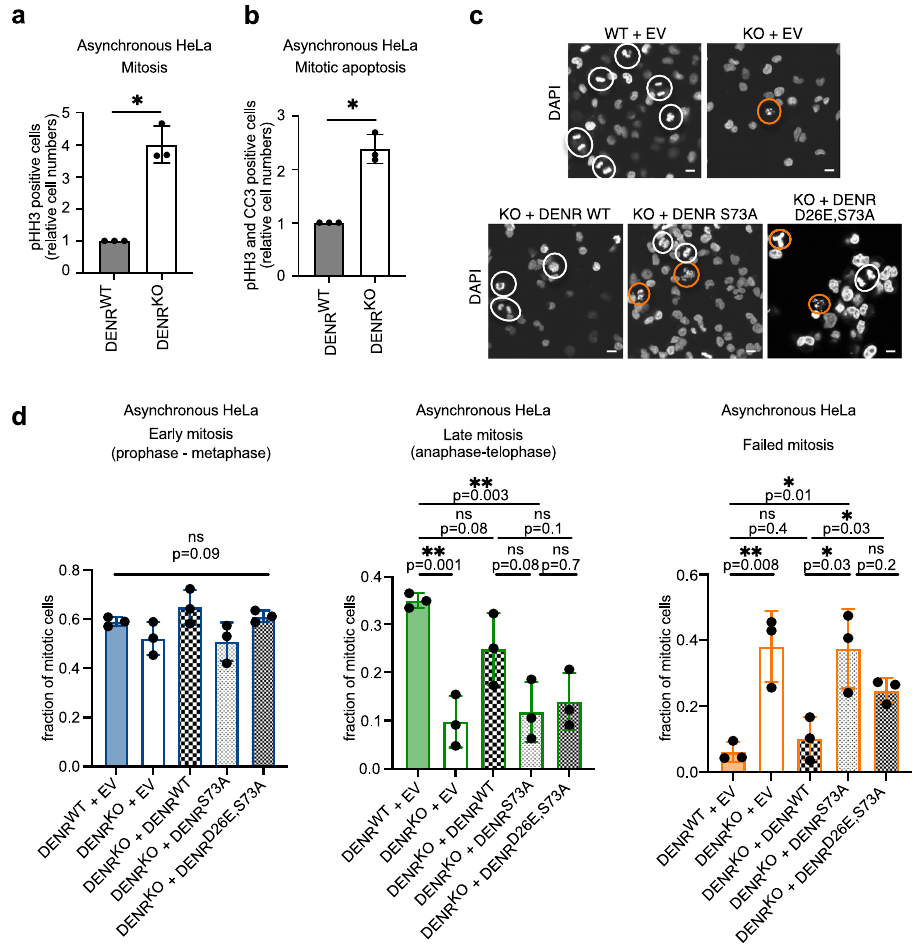
Fig. 5 pDENR (S73) prevents aberrant mitosis and promotes faithful cell division. DENR knockout cells have an elevated proportion of cells in